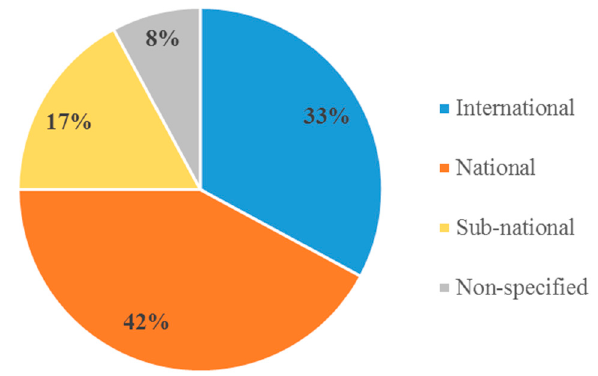
Figure 5. Scope of the institutions funding the